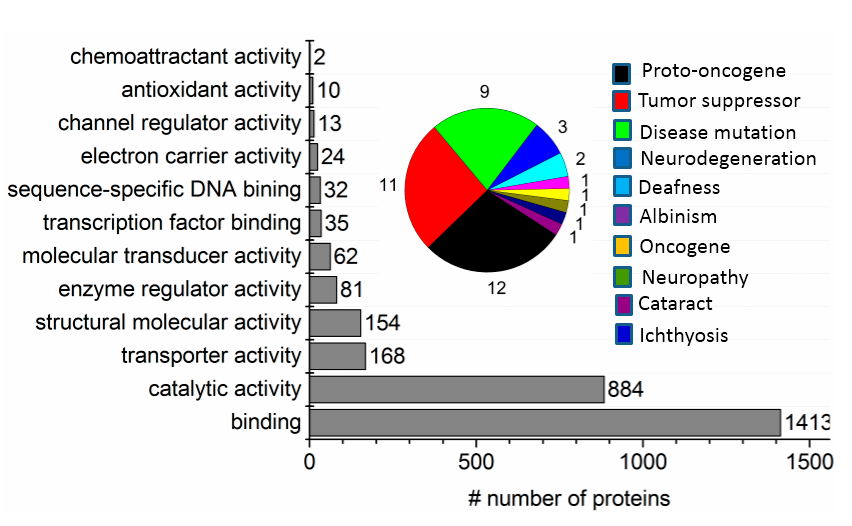
Figure 9. Molecular function classification of all proteins identified with at least one unique matched peptide from six fractions of a whole membrane proteome of cultured mouse myeloma cells fractionated by combination of TX-100 two-phase separation and sequential pH-tuned ND extraction. Pie chart represents proteins associated with biomedical attractions or diseases.